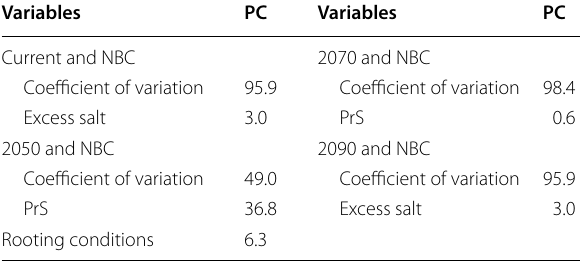
Variables with higher VIP values were used to connect species to their